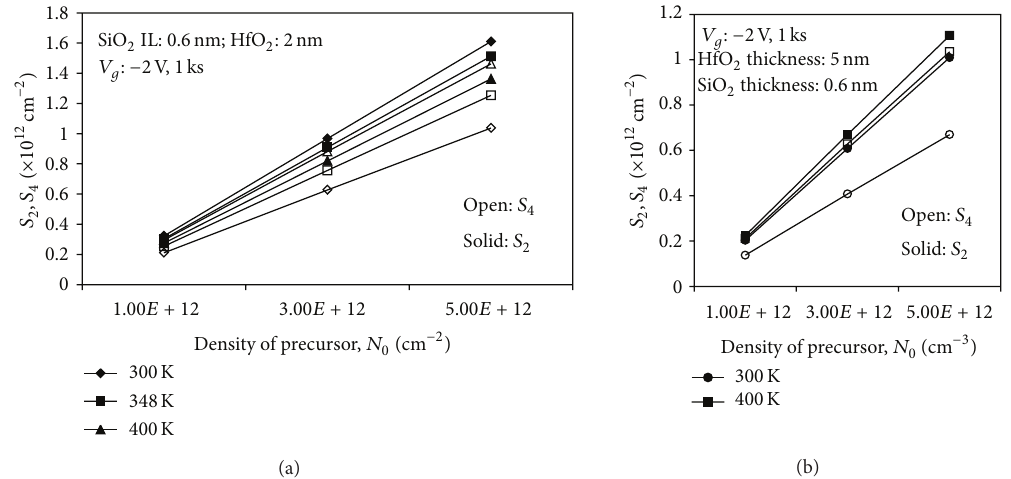
Figure 10: Hole trap density, 𝑆 2 , and interface trap density, 𝑆 4 , as a function of density of precursor under a different stress temperature for (a) thin HfO 2 and (b) thick HfO 2